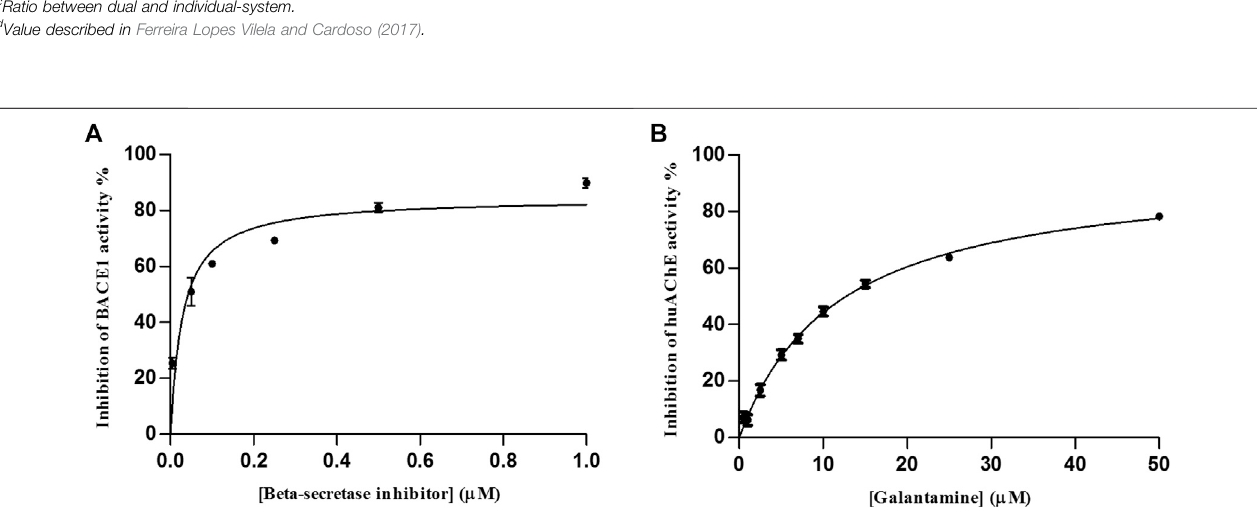
Frontiers in Chemistry |